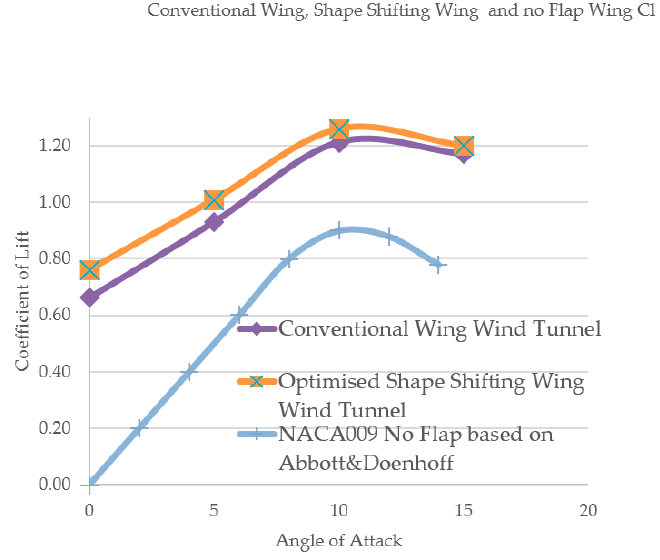
Figure A2. Conventional aerofoil with flap, Initial shape shifting wing design with flap and NACA009 with no flap [30].